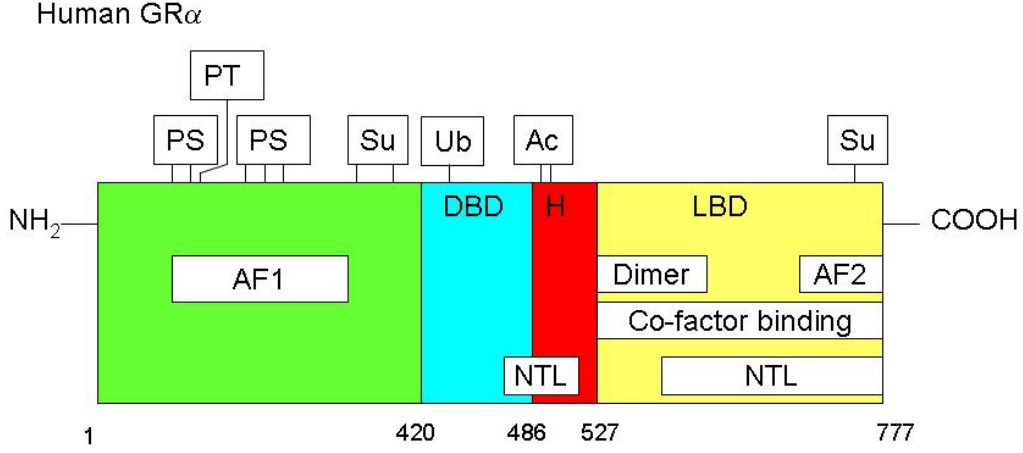
FIGURE 2. Structure of GR α and its post-translational modification. The N-terminus represents the constitutive transcriptional activation function (AF-1). The C-terminus contains the LBD, ligand-dependent activation function (AF-2), dimerization domain, and cofactor binding domains, all separated from the DBD by the hinge region (H). GR is post-translationally modified. Su (sumolyation), Ub (ubiquitinylation), PS (serine phosphorylation), PT (threonine phosphorylation), Ac